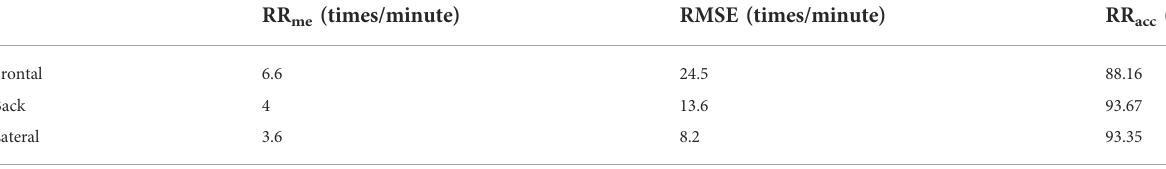
TABLE 6 The test result of different angles between broiler and camera.